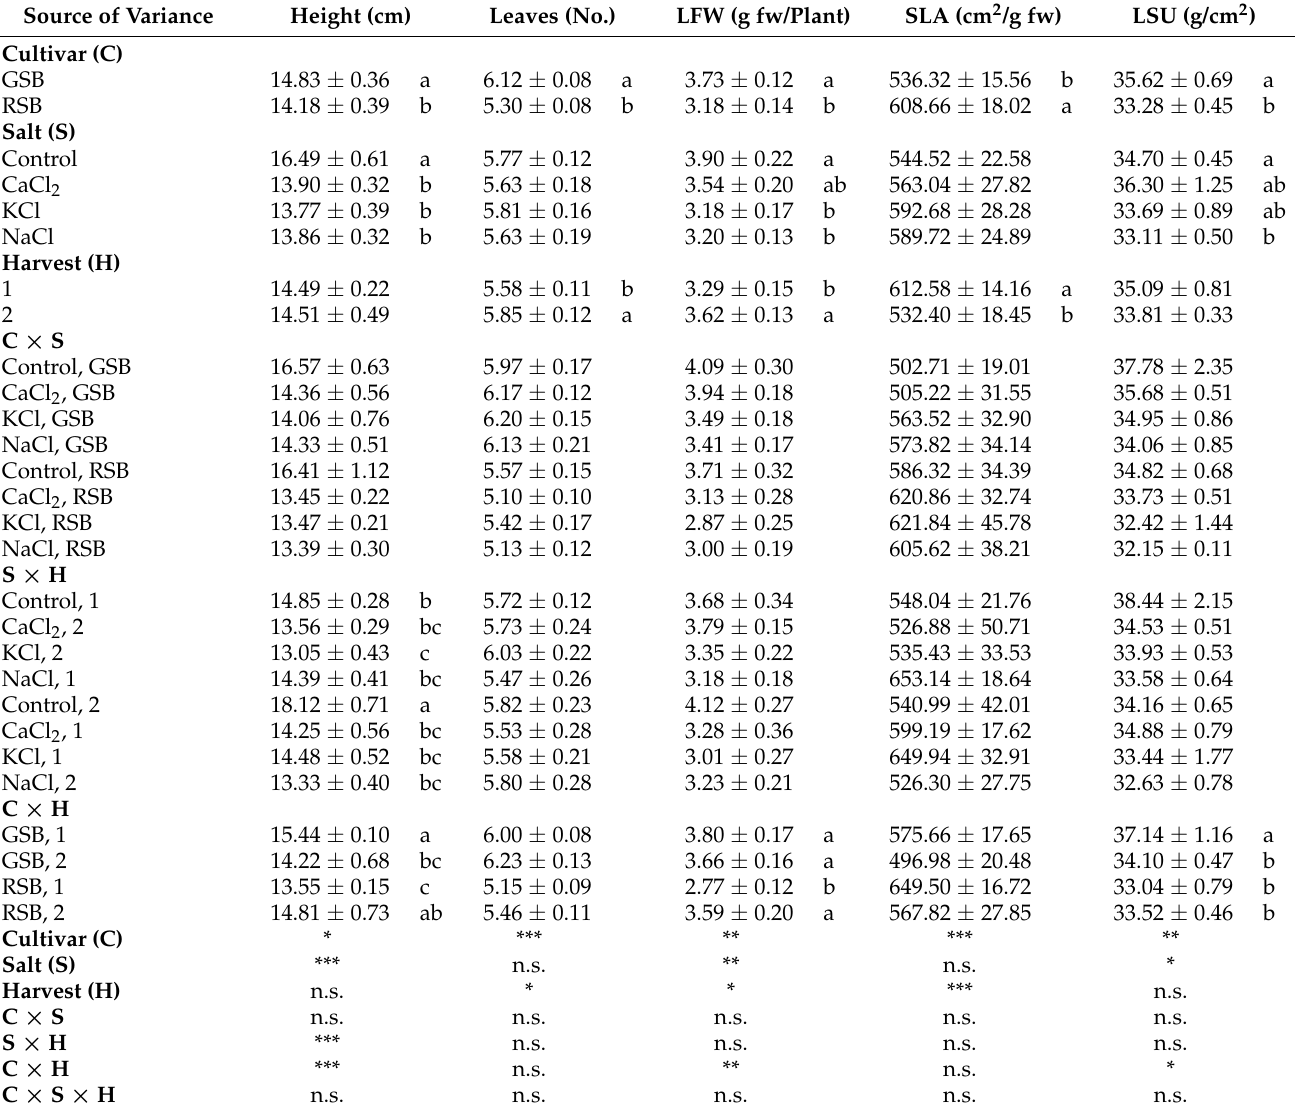
Table 1. Effect of the experimental factors (Cultivar: C, Harvest: H, Salt: S) on the height, number of leaves, leaf fresh weight (LFW), specific leaf area (SLA), and leaf succulence (LSU) of the two baby lettuce varieties, GSB and RSB. The significance of the factors and their interactions was evaluated with a three-way ANOVA, using the Tukey test as a post-hoc test for mean separation among conditions. Data are mean ± SEM. n.s.: not significant; *: p < 0.05; **: p < 0.01; ***: p <